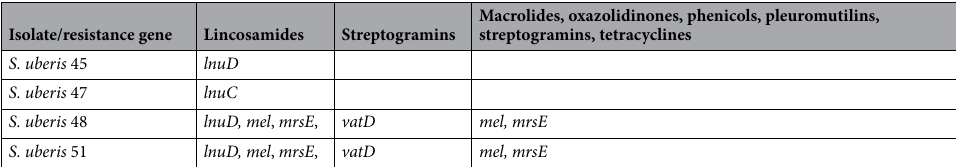
Table 3. Table showing antibiotic resistance profiles of S. uberis isolates in this study. The antibiotic class is shown along the x-axis, and the isolate is shown along the y-axis. The gene responsible for resistance is shown.